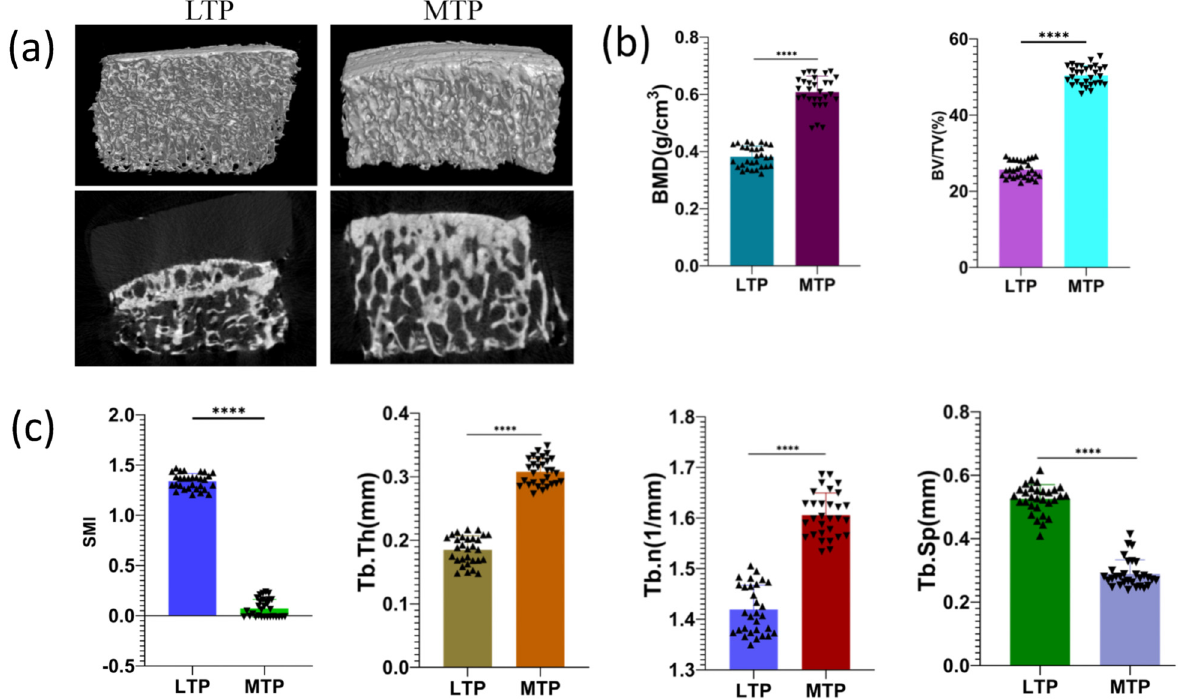
Figure 2: Micro - CTevaluation of the MTP and LTP ofsubchondralbone. ( a ) 2D and 3D micro - CT images. ( b and c ) Quantitative micro - CTanalysis of tibial subchondral bone of bone volume fraction ( BV/TV ) , bone mineral density ( BMD ) , trabecular thickness/number/separation ( Tb.Th, Tb.N, Tb.Sp ) , and structure model index ( SMI ) . The di ff erence between the MTP and LTP groups was statistically signi fi cant. **** P <